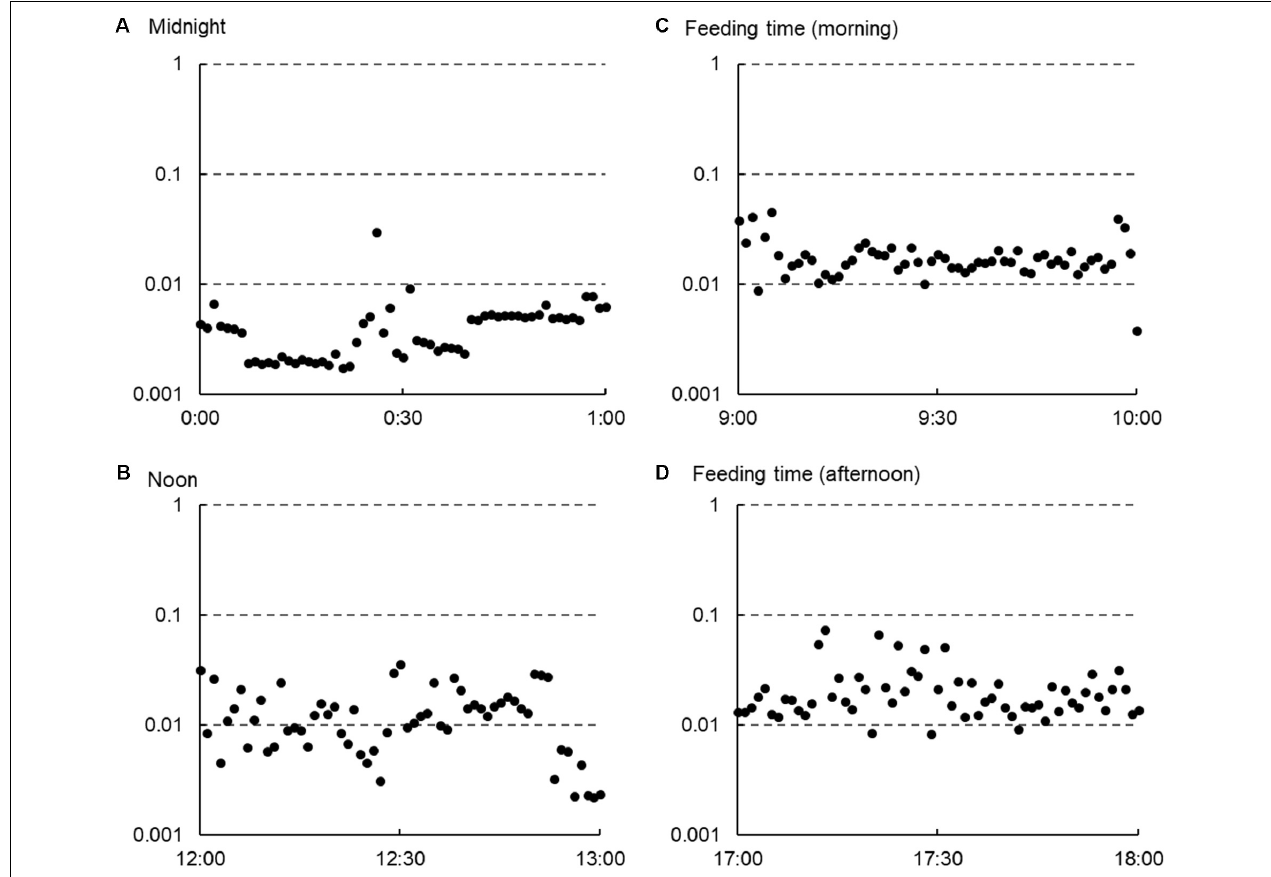
FIGURE 1 | Representative changes in the average raw vectorial dynamic body acceleration (VeDBA: g ) values per minute observed in a cow managed under housing conditions within 1 day. The horizontal axes show the time of day, and the vertical axes show the common logarithmic scale for the raw VeDBA values. The values tended to be stable and lower at midnight (A) , varied and higher at noon (B) , and much higher during feeding times (C , D)